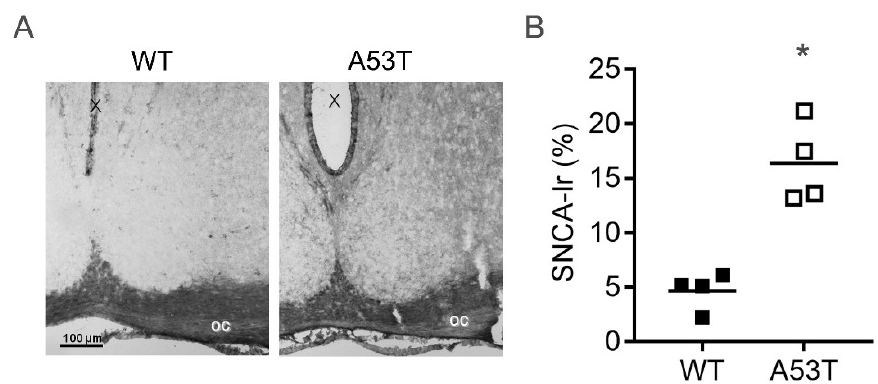
Figure 1. α-Synuclein (SNCA) immunoreaction (Ir) in the suprachiasmatic nucleus (SCN) of wild-type (WT) and A53T-SNCA mice. ( A ) Representative microphotographs of SNCA Ir in the SCN of WT and A53T mice; oc, optic chiasm, X, third ventricle, Bar = 100 µm; ( B ) Semiquantitative analysis of SNCA Ir in the SCN of WT and A53T mice. Data are shown as the area of SNCA Ir in % of the SCN area; *: p < 0.05, Mann–Whitney test.